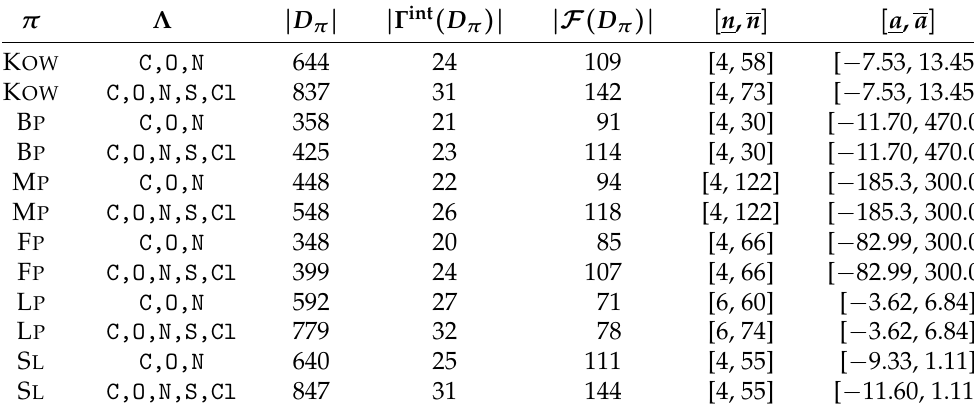
Table 3. Data sets for stage 1 in phase